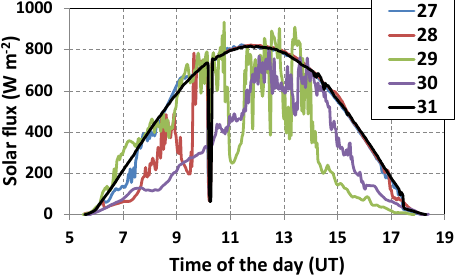
Figure 7. Diurnal cycle for all five days of the pollination event of the total downward solar flux measured in the range 0.3 – 2.8 µm at ground level close to the lidar station.